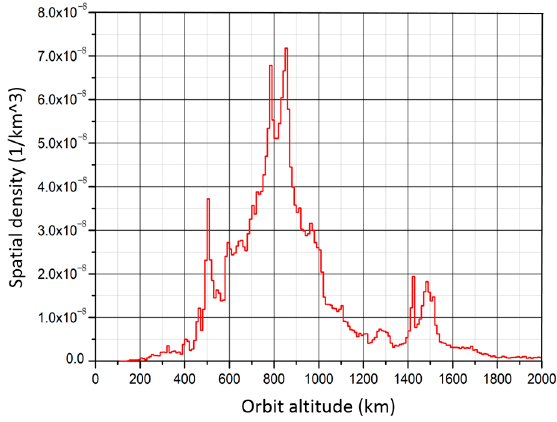
Figure 4. Distribution density of the space objects at different orbital altitudes.